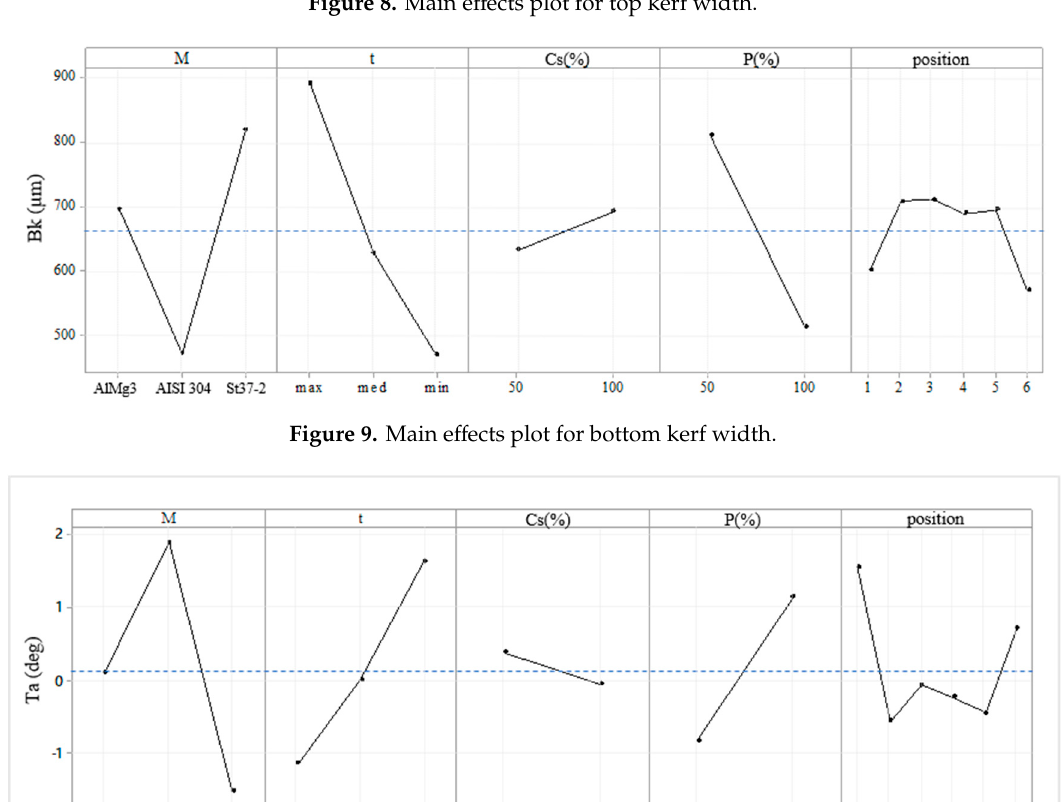
Figure 11. Main effects plot for kerf section. Figure 12. Interaction plot for top kerf width. 3.2. Effect of Process Parameters on Surface Roughness The side cut appears as a finely grooved surface with regular patterns or drag lines. From the observation of the cutting surface, it is generally possible to distinguish three different zones moving downward in the cutting direction: the upper edge of cut, which is characterized by lower surface roughness; the lower edge of cut, which exhibits higher surface roughness and, in some cases, slug;